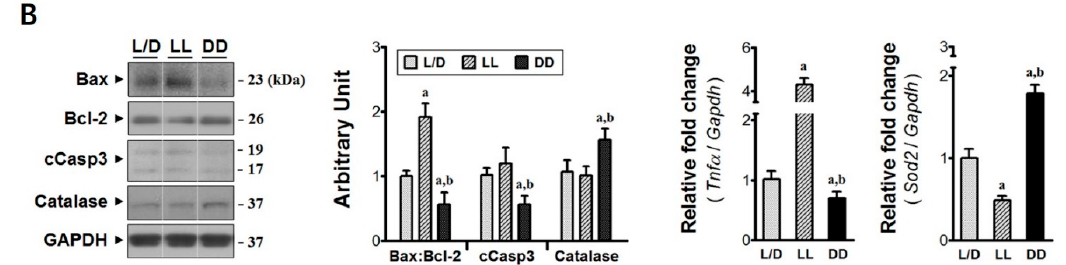
Figure 3. The neuroprotective effects of elevated melatonin on the primary injury region through regulation of anti-inflammatory and anti-oxidant genes. The damaged segments of spinal cord (T9-11) were analyzed at POD 3. ( A ) LL condition exacerbated the histological deterioration of the primary lesion, where Iba1 expression (microglial marker) was upregulated. DD condition not only protected injured tissue but also increased the levels of endogenous pluripotency markers (Nestin, Vimentin, Oct4 ), neuron (NeuN), and oligodendrocytes (Olig2). Magnification = ×200; Scale bar = 40 μ m; ( B )